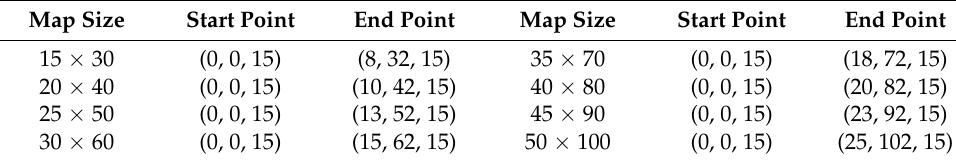
Table 2. Coordinates of start and end points in maps of different